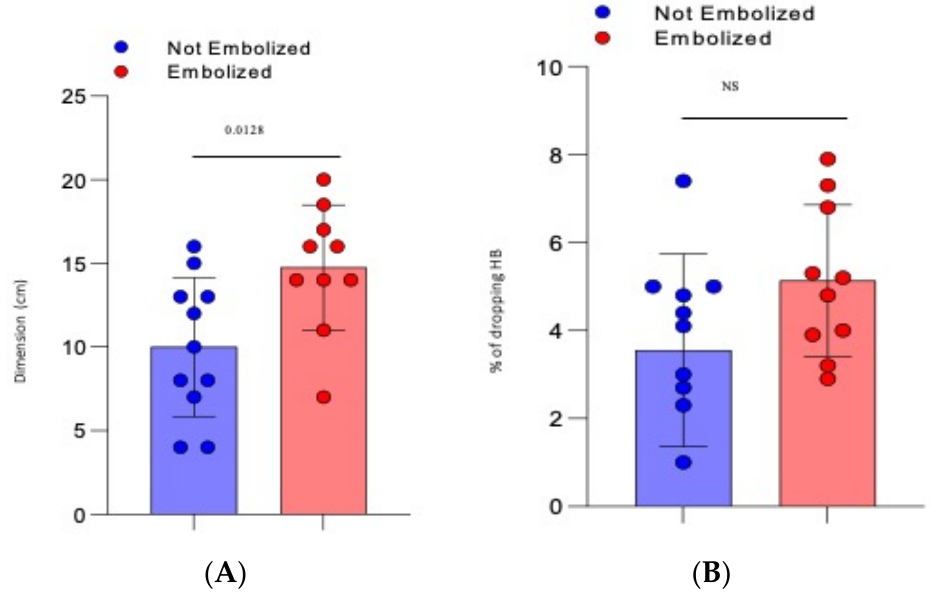
Figure 1. Severity criteria within the two groups: ( A ) Dimension of the hematoma (considered as the sum of the two major diameters on the three planes ÷ 2); ( B ) % of dropping of hemoglobin (>2–3 g/dL).